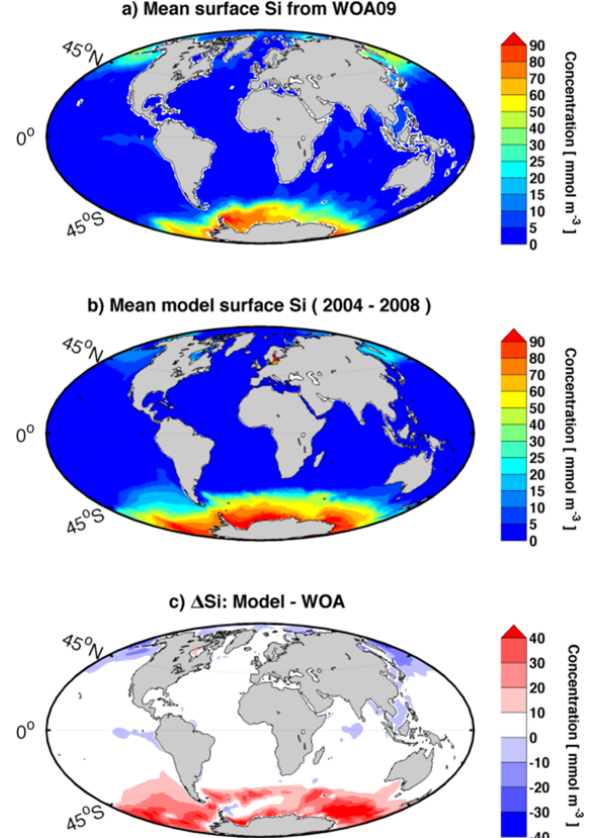
Figure 8. Spatial distribution of mean surface concentration of dissolved inorganic silicon. (a) Observed (Garcia et al., 2010) (b) Modelled. (c) Residual: modelled − observed.